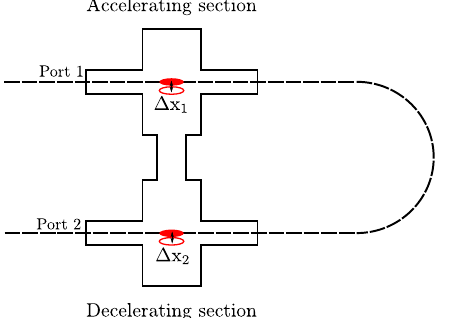
FIG. 2. Schematic of asymmetric ERL structure with accel- erated and decelerated bunches. The bunch without red filling indicated the bunch which deviated from the central line